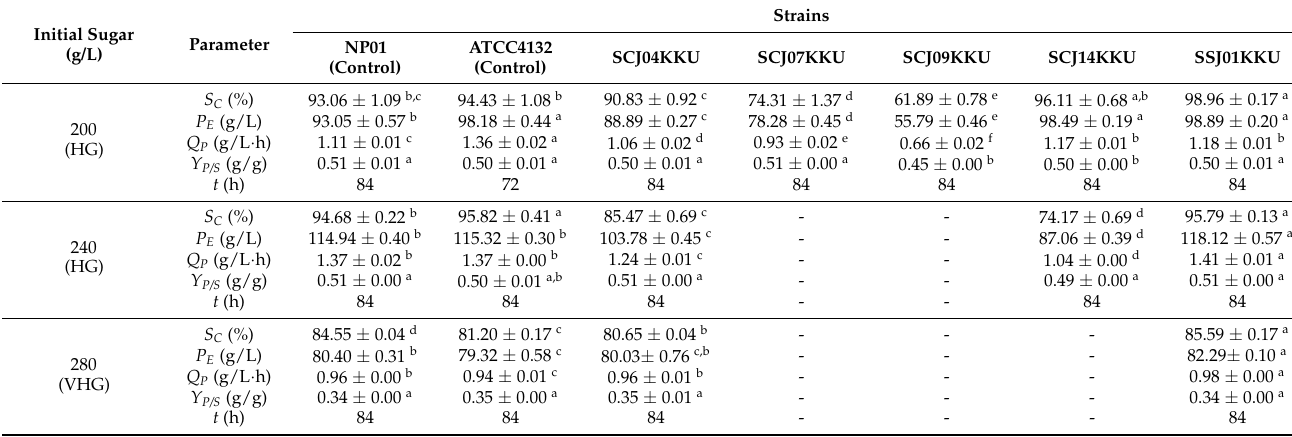
HG = high gravity, VHG = very high gravity, SC = sugar consumption, P E = ethanol concentration, Q P = ethanol productivity, Y P/S = ethanol yield and t = fermentation time. - = not tested. The results were performed in triplicate and expressed as mean ± SD. a,b,c,d,e,f Means followed by the same letter within the same row are not significantly different using Duncan’s multiple range test at the level of